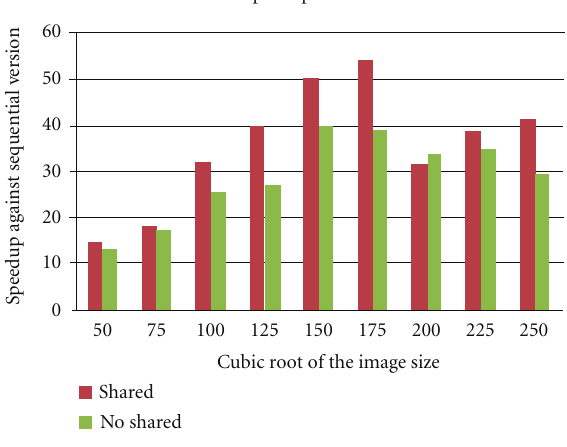
Table 2: Raw runtimes of the algorithm on the C1060 system.